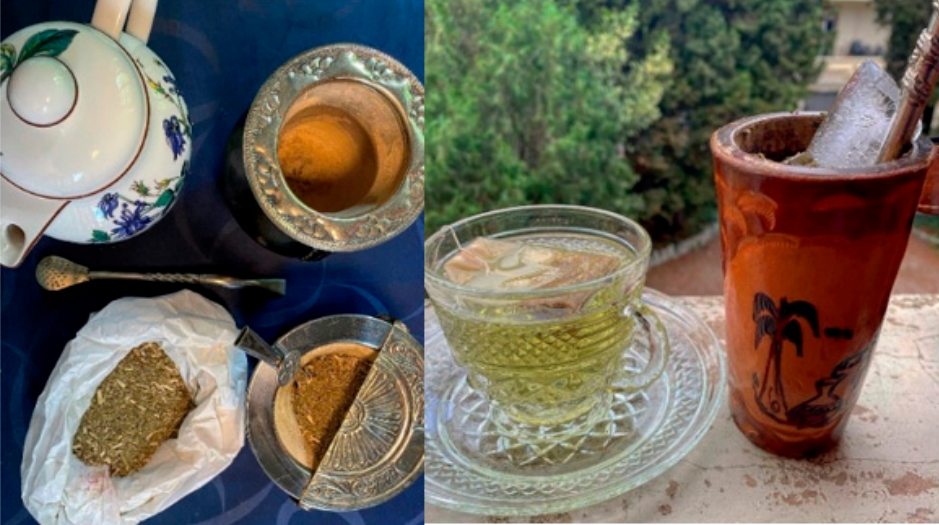
Figure 3. Yerba mate infusion, cocido and terere (authors’ photograph).